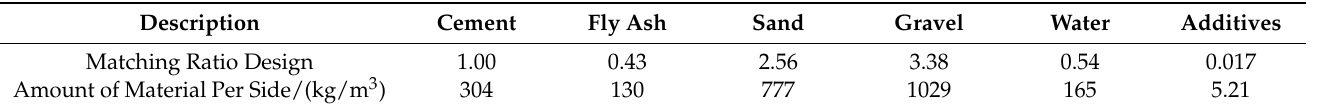
Table 4. C35 concrete mix ratio